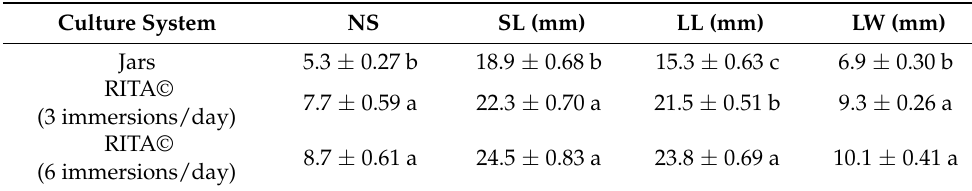
Table 1. Effect of the number of immersions and the culture system on the growth of the plum genotype CBP cultured with 3% sucrose. (a) Shoot length (SL), length (LL) and width (LW) of the largest leaf; (b) Number of shoots (NS). Data are mean values and standard error of 48 explants. Different letters indicate significant differences ( p <